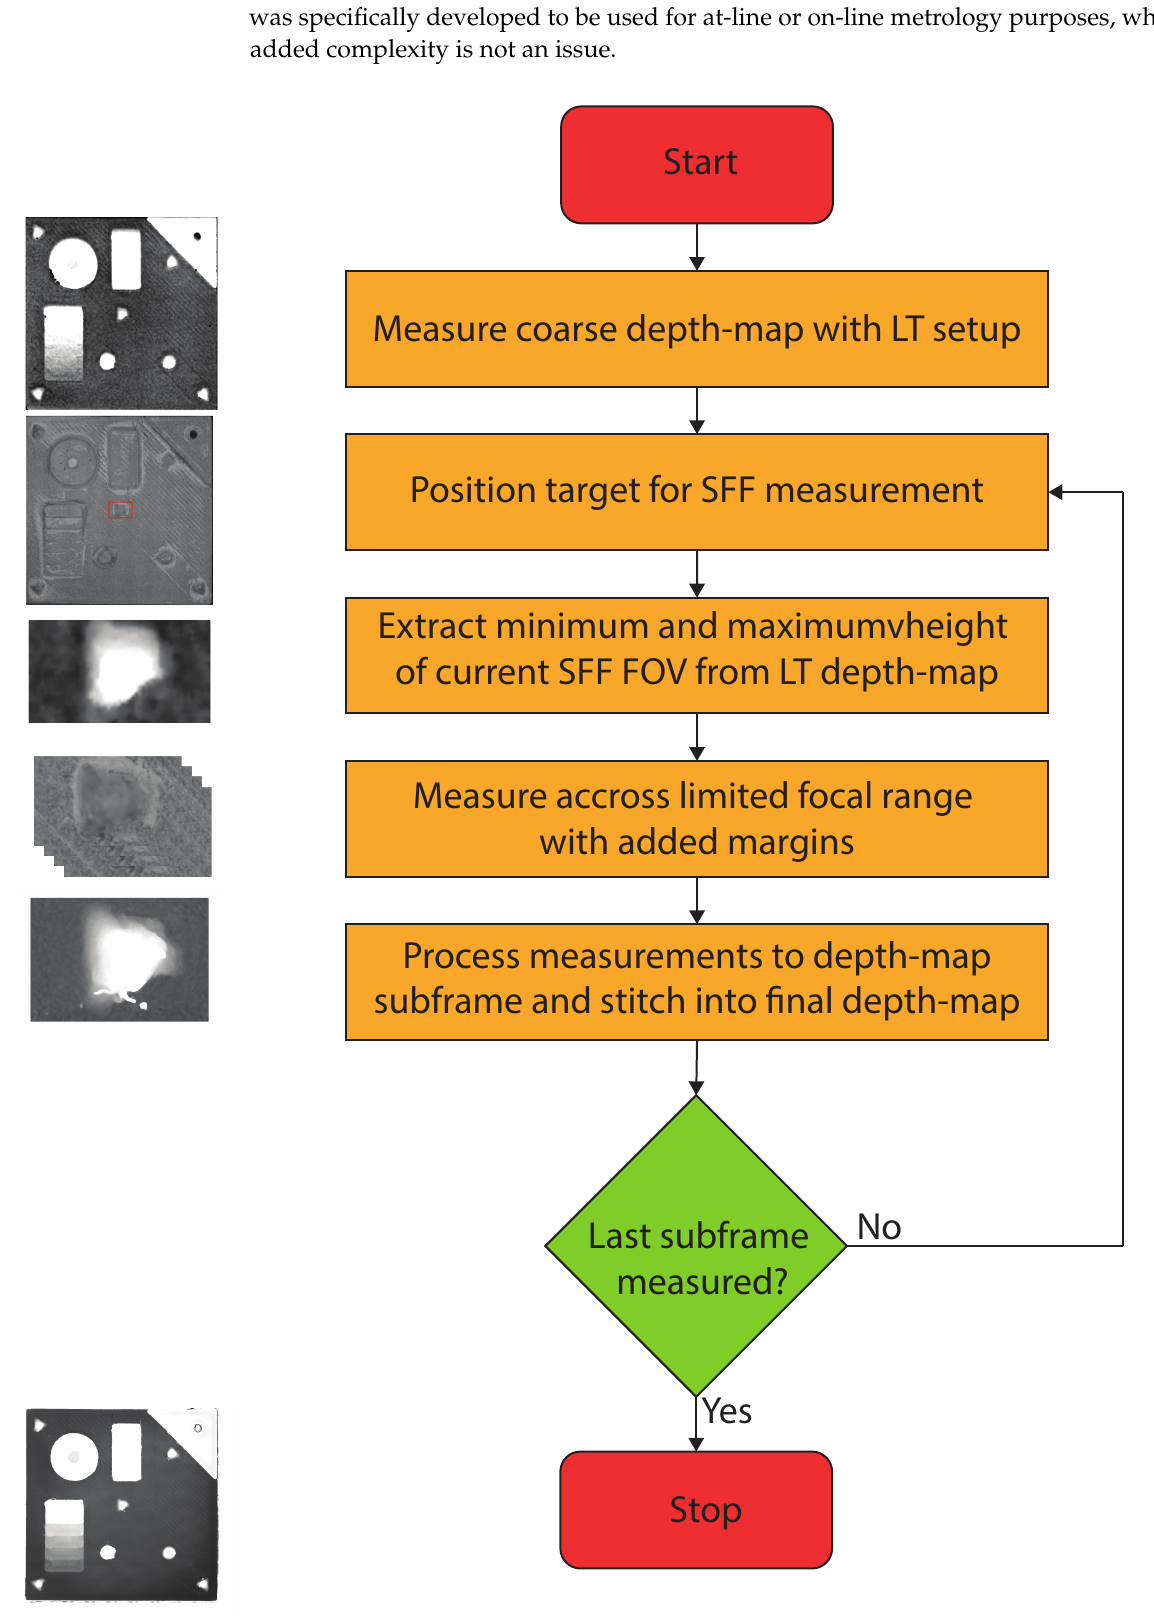
Figure 8. Flowchart of the measurement principle of combining laser triangulation (LT) and shape from focus (SFF) techniques to speed up stitched SFF